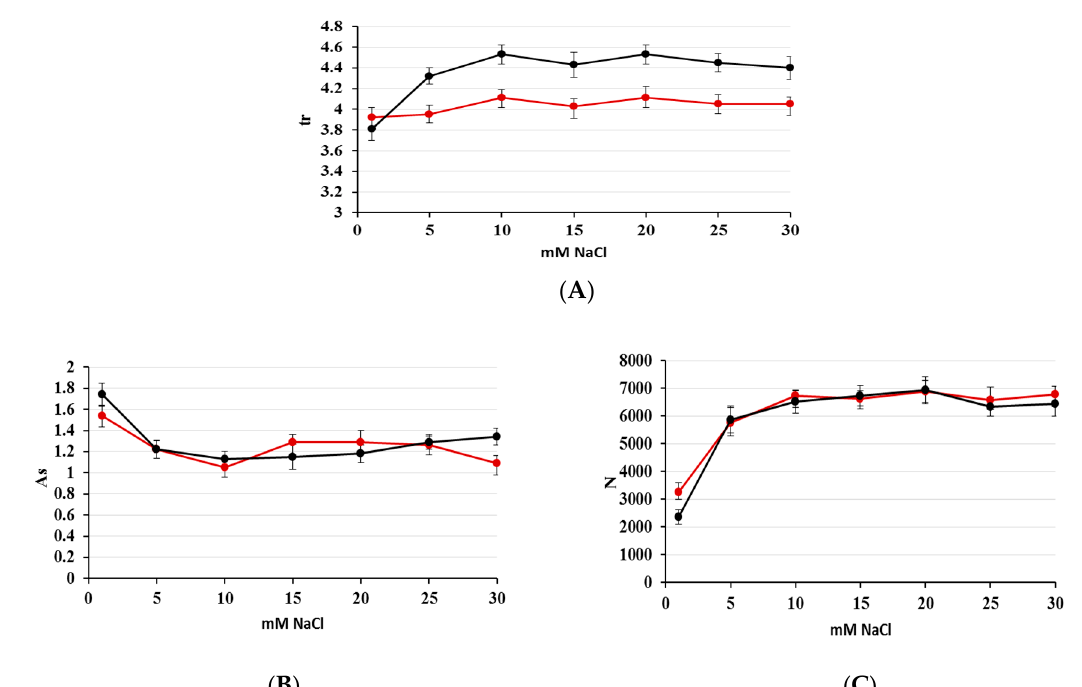
Figure 2. The e ff ect of NaCl concentrations in the range of 1–30 mM (1, 5, 10, 15, 20, 25, 30 mM) in the aqueous mobile phase on NO 2 − (red line) and NO 3 − (black line) peak parameters: tr ( A ), A s ( B ), N ( C ). Abbreviations: tr, A s and N denote retention time in minutes, asymmetry factor (the Hitachi High-